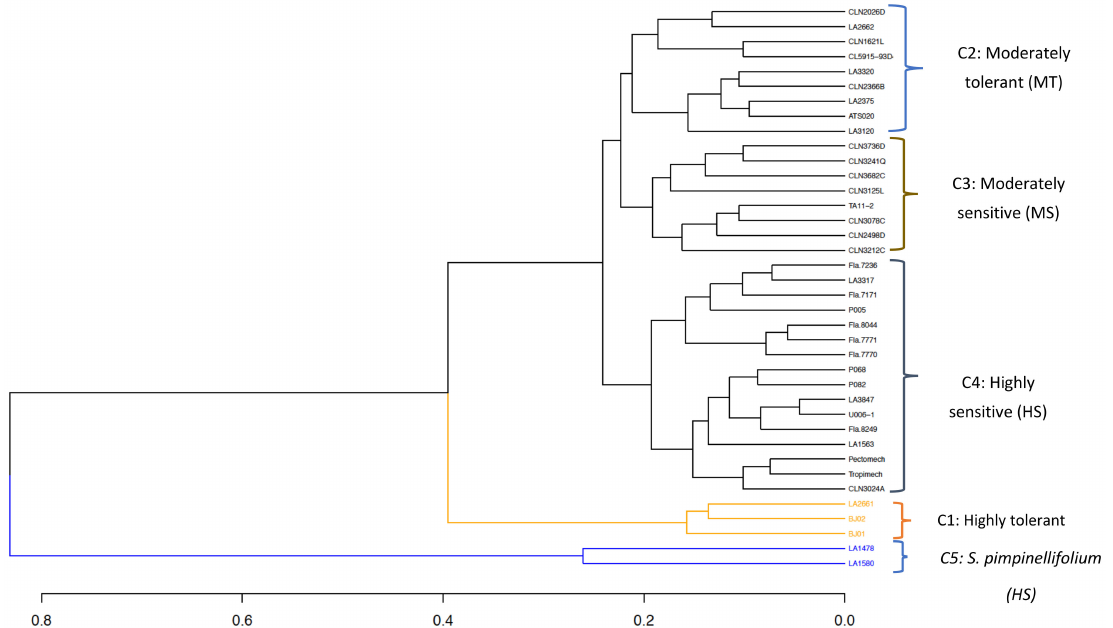
Figure 7. Clustering based on combined phenotypic and genomic distance matrices of a tomato germplasm collection. C denotes